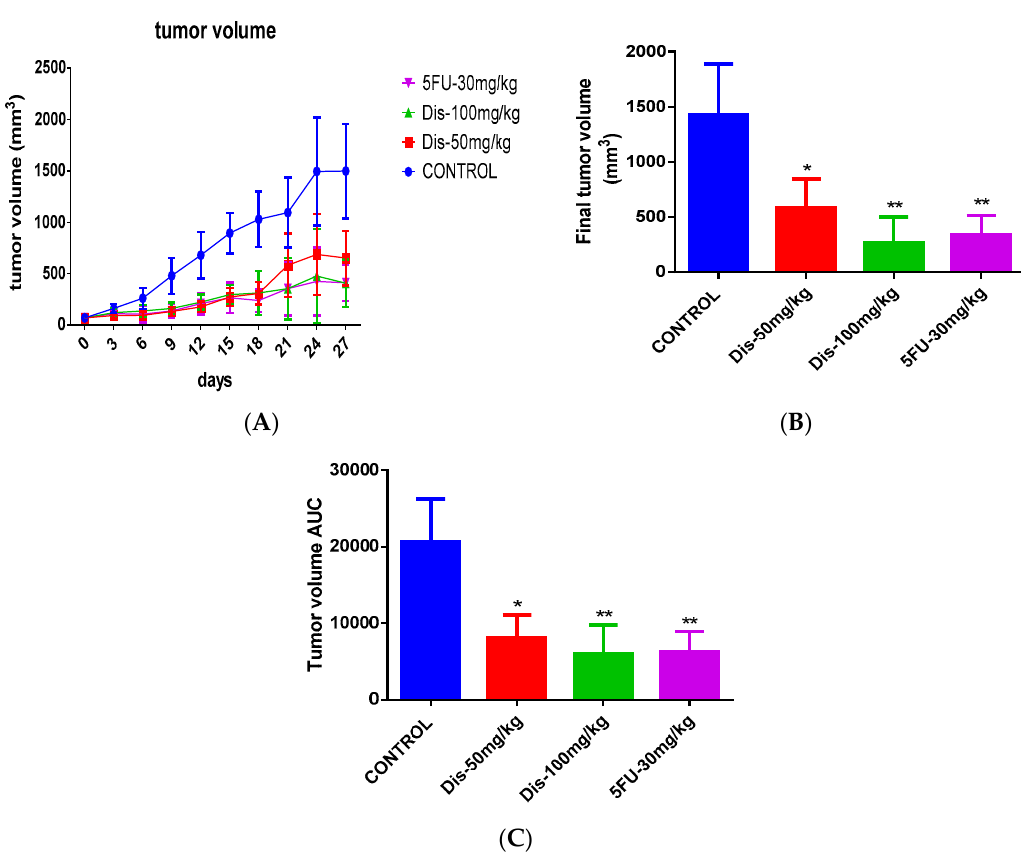
Figure 3 . Tumor volume growth and final tumor volume of treated and untreated mice. A : Tumor volume growth in control and treated groups during 27 days of treatment. B : Final tumor volume of treated and untreated groups. C : Area under the curve (AUC) measurement of the overall changes in tumor volume of treated mice compared to untreated group. Data were expressed as mean ± standard deviation. * p < 0.05, ** p < 0.01 indicate significant differences compared to control .